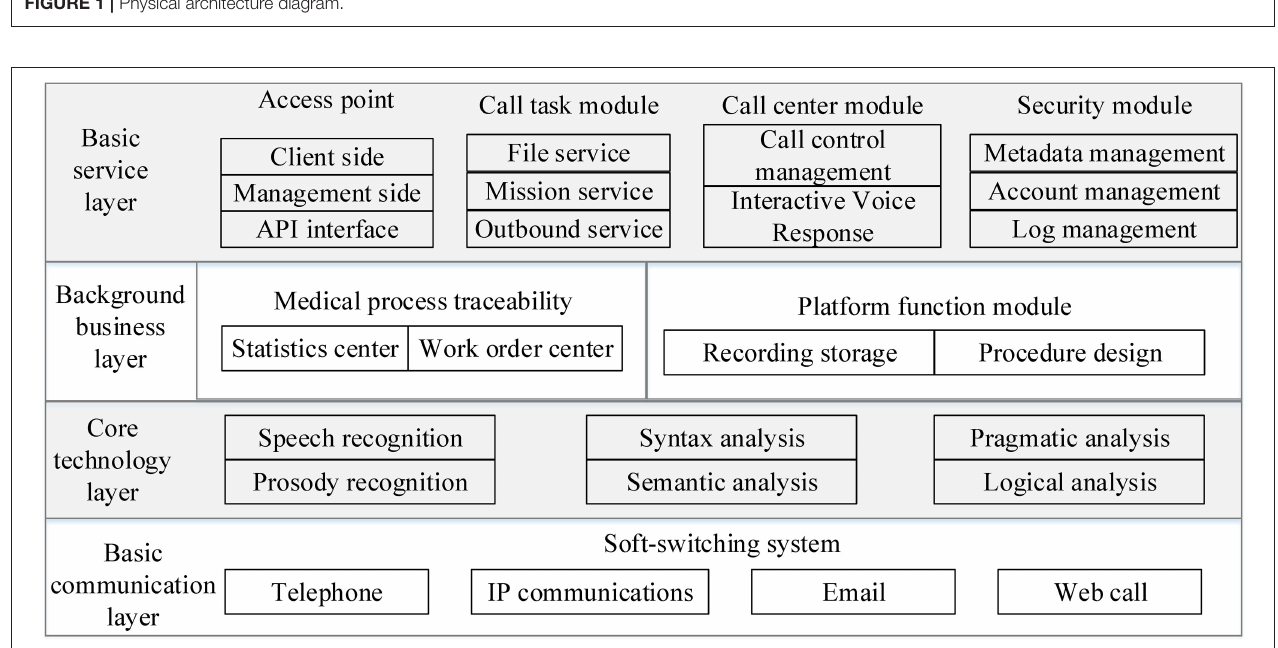
FIGURE 1 | Physical architecture diagram.